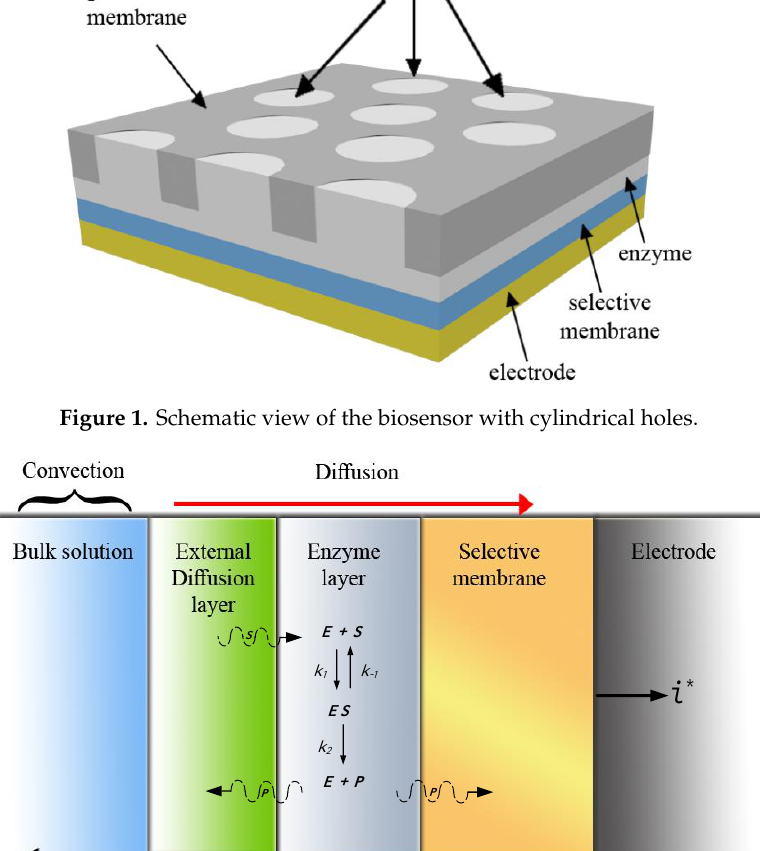
Scheme 1. Different regions of an amperometric biosensor . Scheme 1. Di ff erent regions of an amperometric